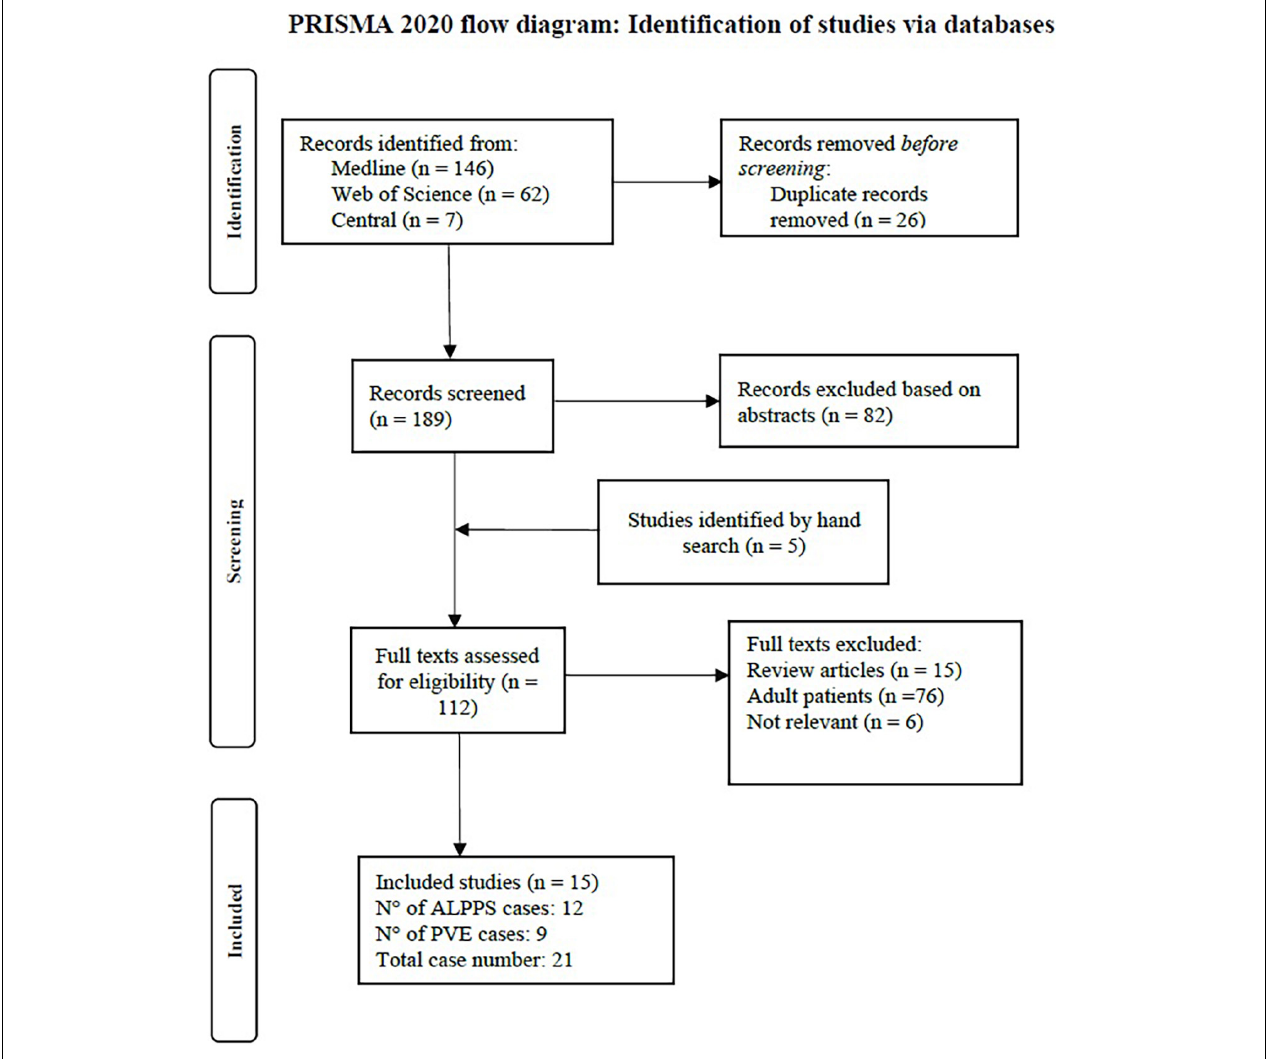
FIGURE 1 | PRISMA flow chart of the study selection and inclusion